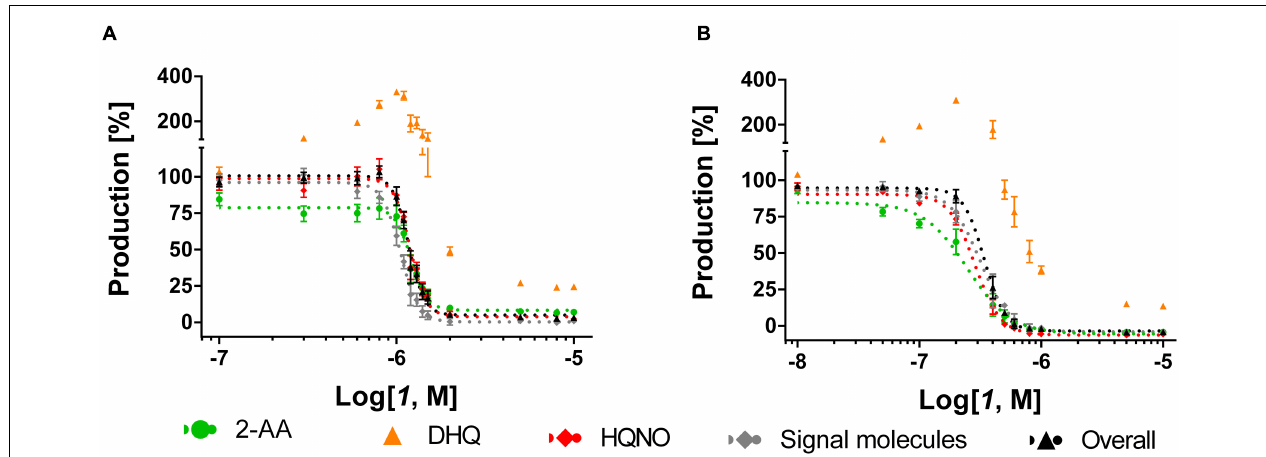
FIGURE 3 | Dose-response curves of MvfR antagonist 1 acting on MvfR-related small molecules production in PA14 wt (A) and PA14 pqsH mutant (B) . 2-AA: green. DHQ: orange. Signal molecules: gray. HQNO: red. Sum of all anthranilic acid derivatives: black. The “ x ” axes indicate the logarithm of the concentration of the antagonists in molar units (M). The error bars indicate Standard Error of the Mean. TABLE 2 | Effects of MvfR antagonist 1 on 2-AA and DHQ production in PA14 pqsC mutant with and without external addition of PQS. Compounds